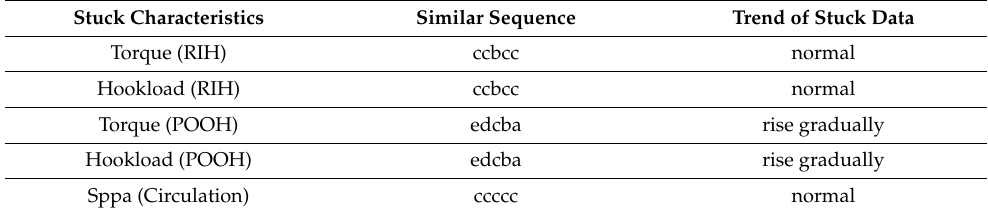
Table 11. Recognition results of the stuck data from 4:55 to 5:05 using SAX